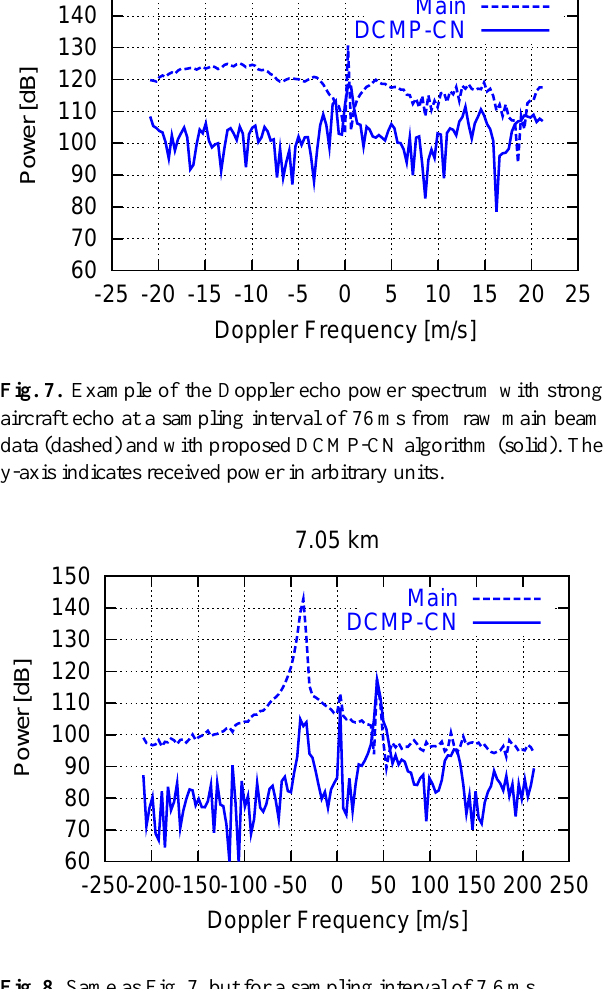
Fig. 8. Same as Fig. 7, but for a sampling interval of